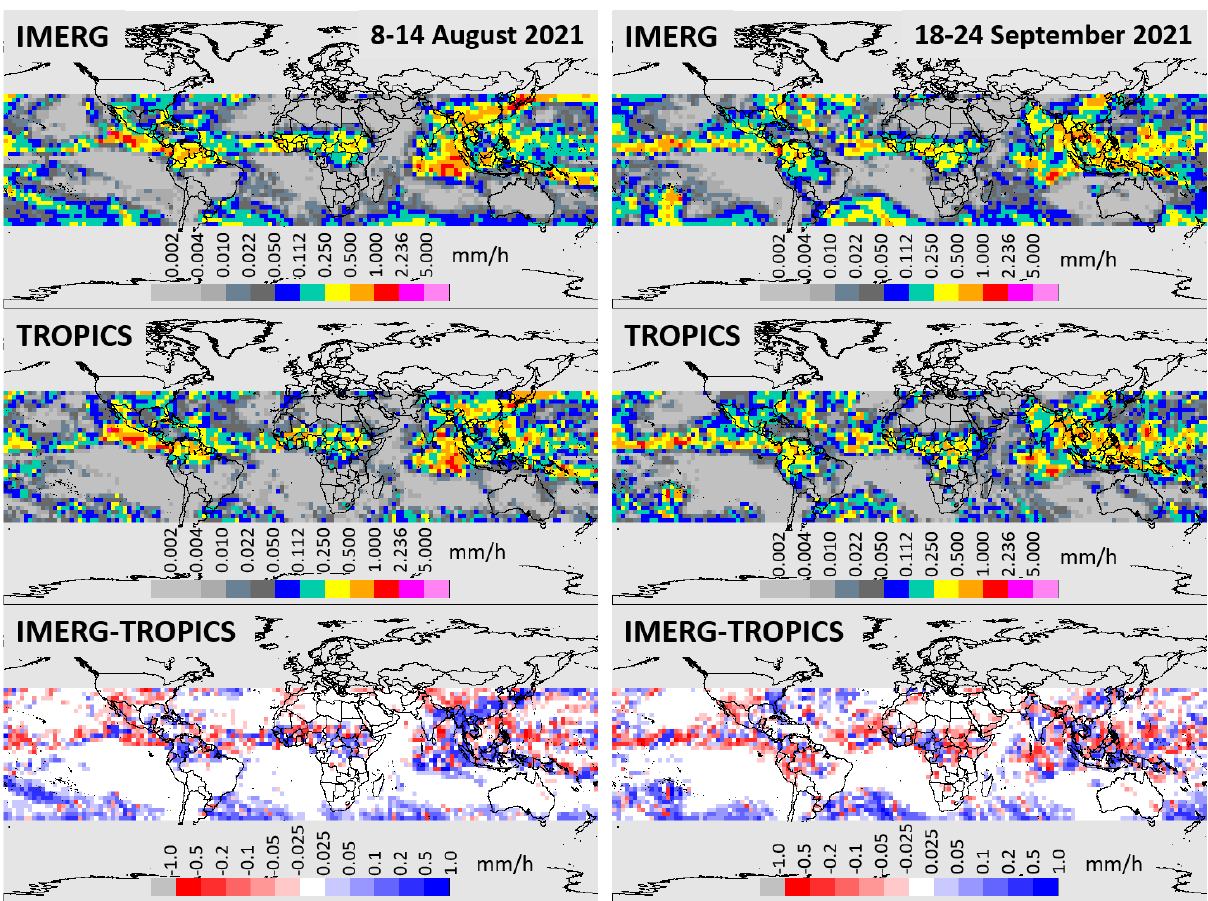
Figure 4. Comparison of the IMERG product ( top ), the TMS product ( middle ), and the difference ( bottom ) for 8–14 August 2021 ( left ) and 18–23 September 2021 ( right ). Note that the IMERG product is the average of 336 30 min estimates, compared with a maximum of 14 instantaneous estimates from the TMS.